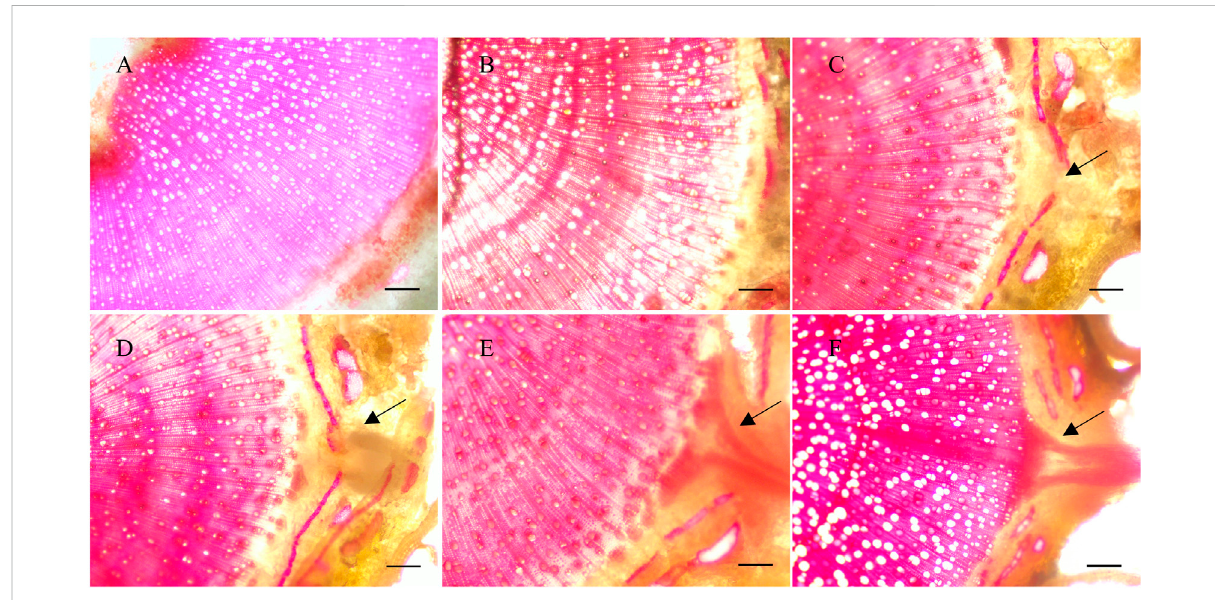
FIGURE 1 Dissectionofrootformationin Populusxiaohei cuttingstreatedwithwater. (A – F) Cross-sectionalviewofthebaseof P.xiaohei cuttingsfor0,2, 4, 6, 8, and 10 days. Arrows indicate the development area of root primordium cells between the cambium and epidermis (bars = 100 μ m).